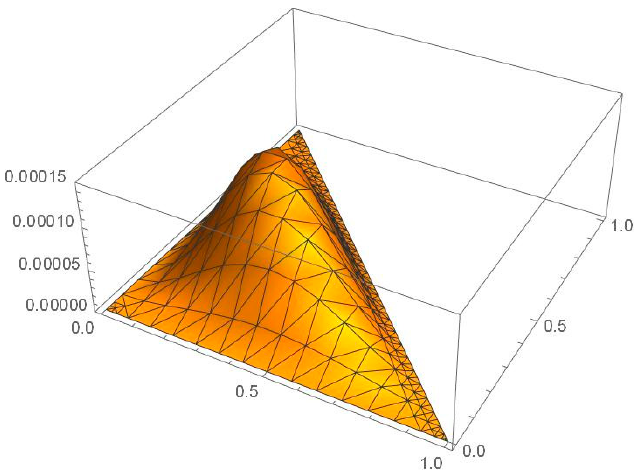
Figure 4. 3D plot of clamped plate normal deflection (C-C-C); the flexural rigidity p / D = 1.